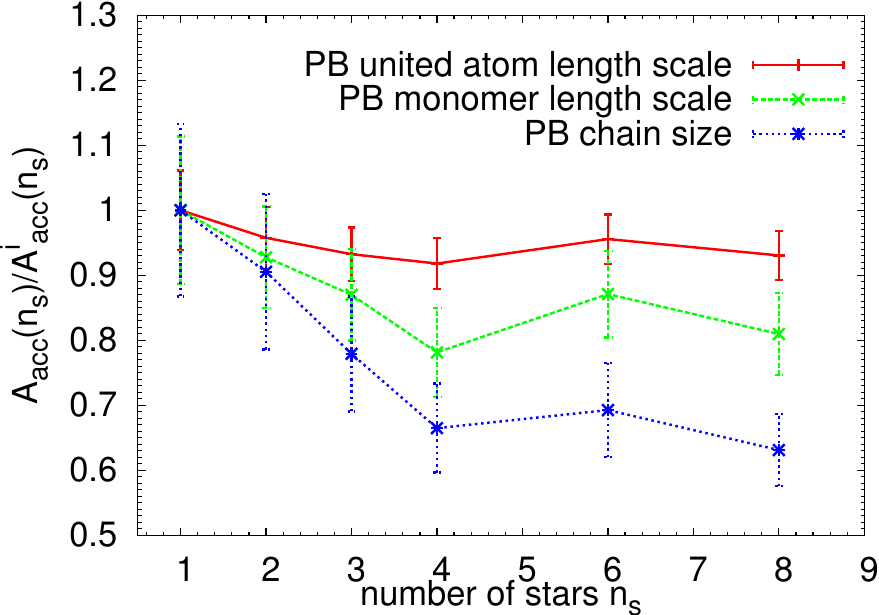
Figure 7. Accessible surface area A acc ( n s ) normalized with a value for the ideally dispersed system A i acc ( n s ) as a function of number of stars in the system, n s . The accessible surface area for the ideally dispersed system was calculated as A i acc ( n s ) = n s A acc ( 1 ) , where A acc ( 1 ) is the value obtained for s1/PB. Different symbols represent different radii of the “solvent” probe, i.e., in our case, different characteristic length scales of the PB matrix. The lines are guide for the